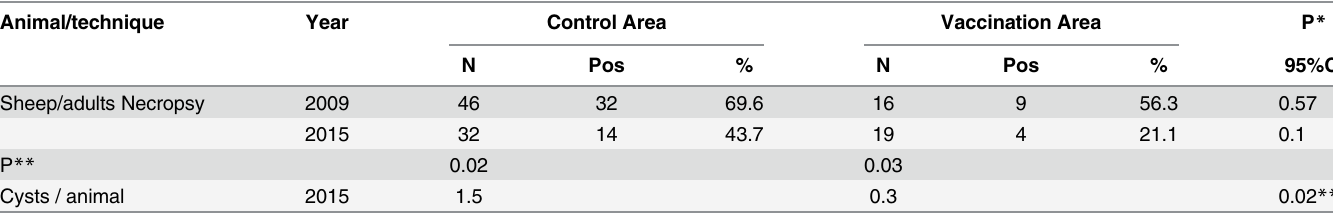
Table 3. Diagnostic values for Echinococcus granulosus obtained as base-line data and impact before and after the introduction of the EG95 vac- cine in the Rio Negro control program during 2009/2015.